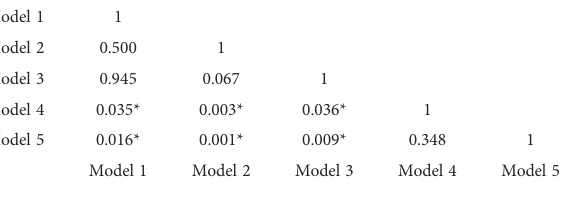
TABLE 3 Delong test between models 1-5.